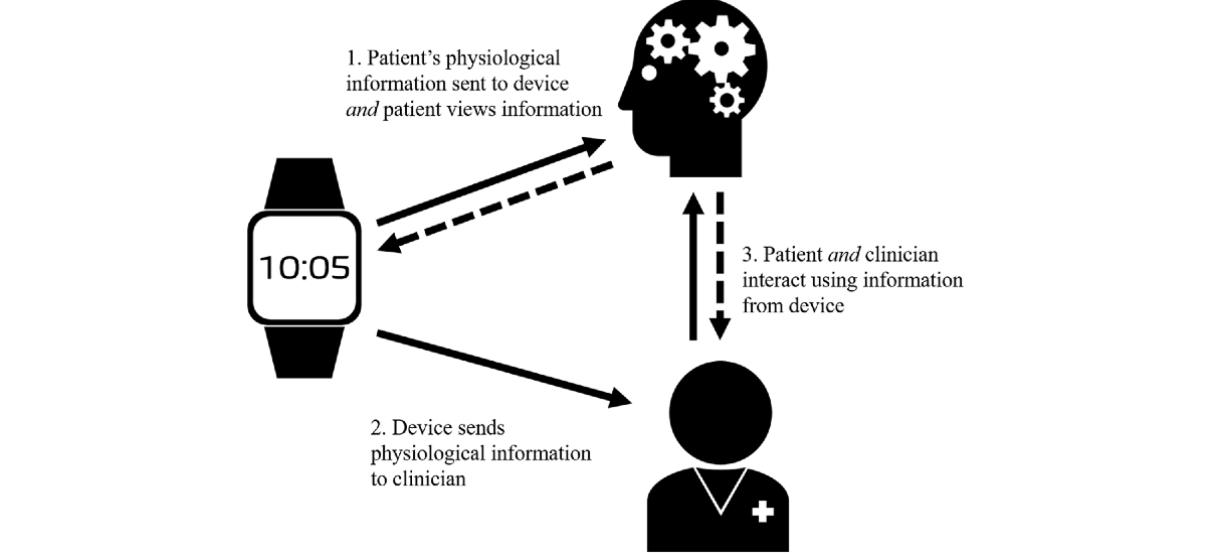
Figure 1. Information flow between patient, clinician, and integrated mobile health